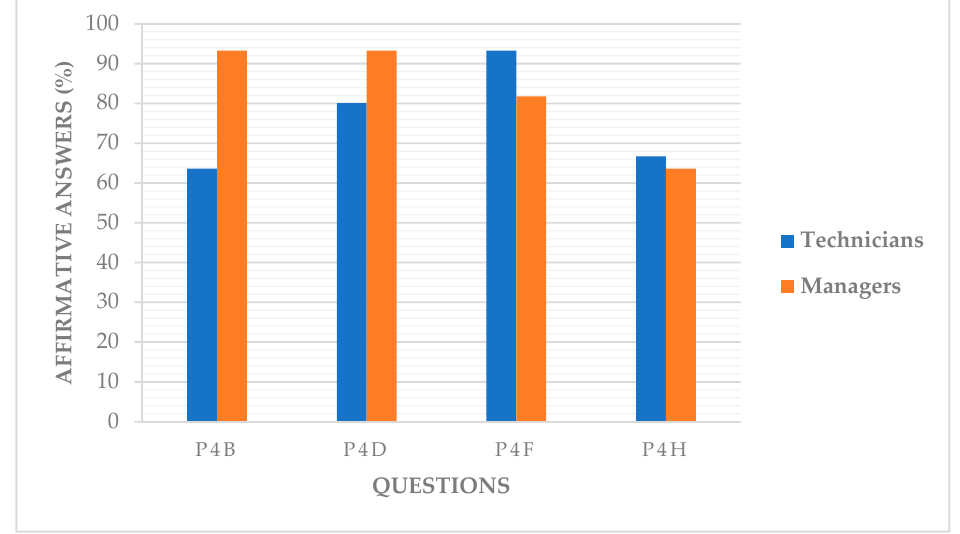
Figure 8. Answers for questions in Block 3 (technicians and managers).